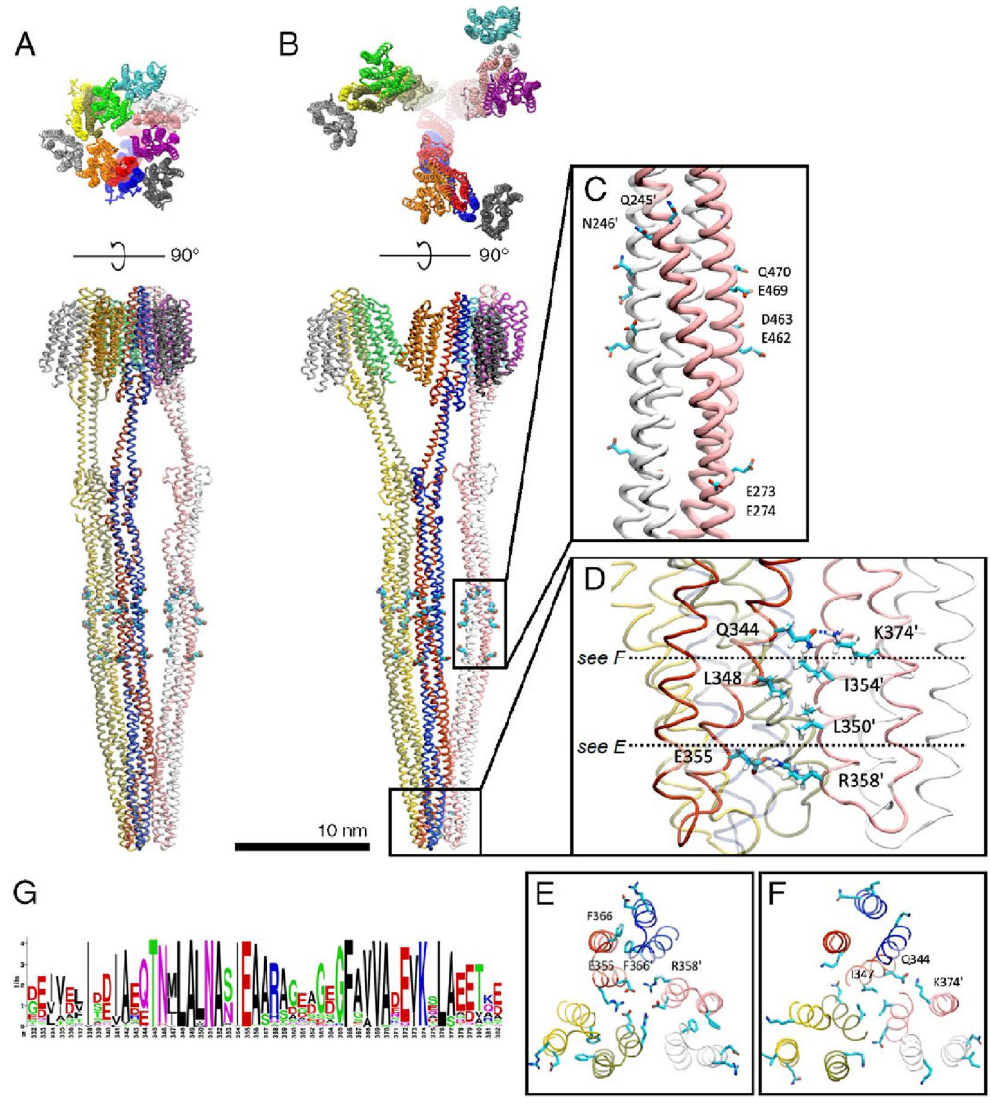
Figure 4. Optimized molecular models of the Np SRII/ Np HtrII trimer of dimers. ( A,B ) Molecular models of the "transmembrane-bound" ( A ) and the "tripod"-shaped ( B ) trimer of dimers. Individual polypeptide chains are colored differently. Putative methylation sites are represented as spheres. ( C ) Putative methylation sites in the methyl-accepting region of a single dimer of the complex. ( D ) Inter-dimer contacts within the highly conservative tip region of the cytoplasmic domain of the "tripod"-shaped trimer of dimers. Key amino acid residues are shown with those belonging to the partnering dimer labeled by apostrophe. ( E ) Cross-section view highlighting the formation of ionic locks between E355-R358’ (homologous to E385 and R388’ from Tsr 42 and stacking between F366 (equivalent to F396 of Tsr) and F366’. ( F ) Cross section depicting contacts between conservative K374’ and Q344 residues, and hydrophobic contacts between I347. ( G ) Logo plot showing conservation of residues in the tip region involved in the formation of the trimer